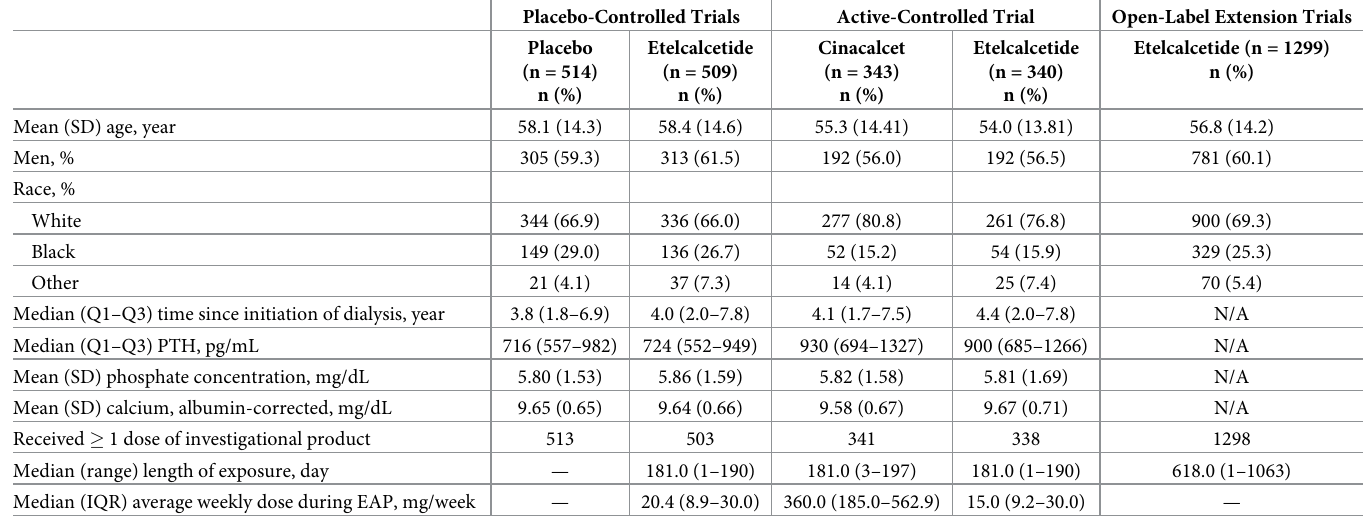
Table 1. Baseline characteristics and